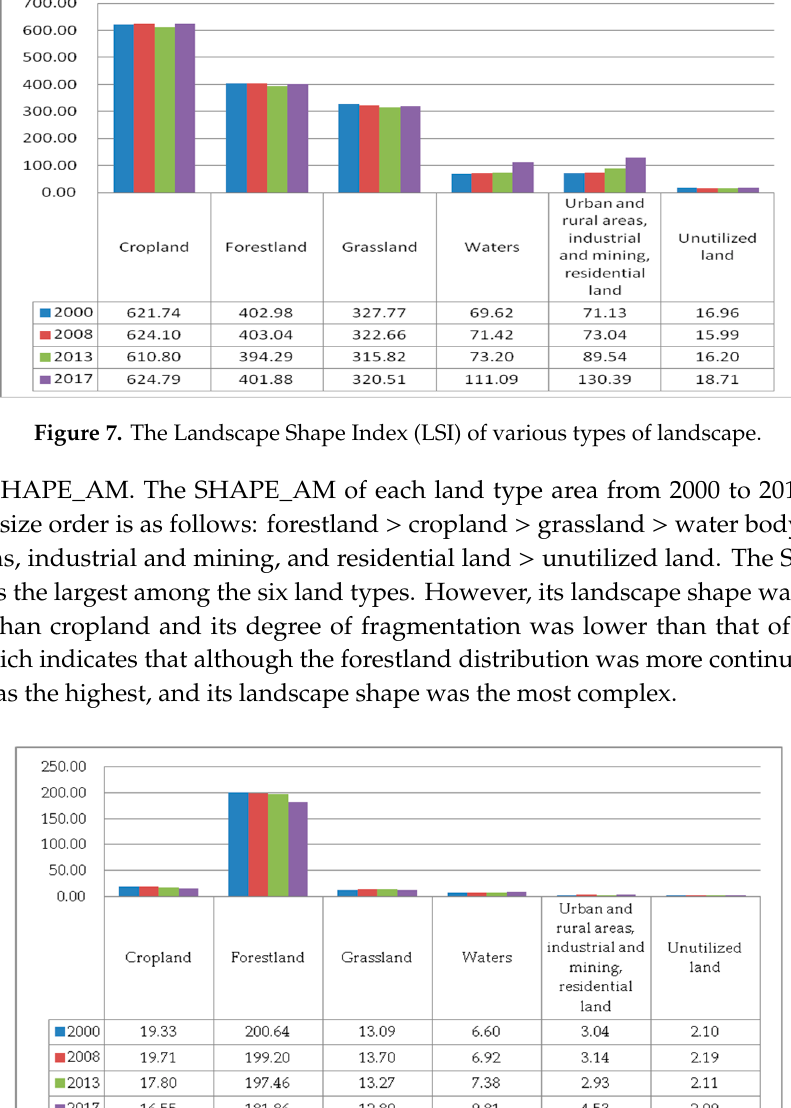
Figure 6. The mean of patch area (AREA-MN) changes of various type of landscapes. (a) The AREA-MN in 2000; (b) the AREA-MN in 2008; (c) the AREA-MN in 2013; (d) the AREA-MN in 2017 (unit: ha).